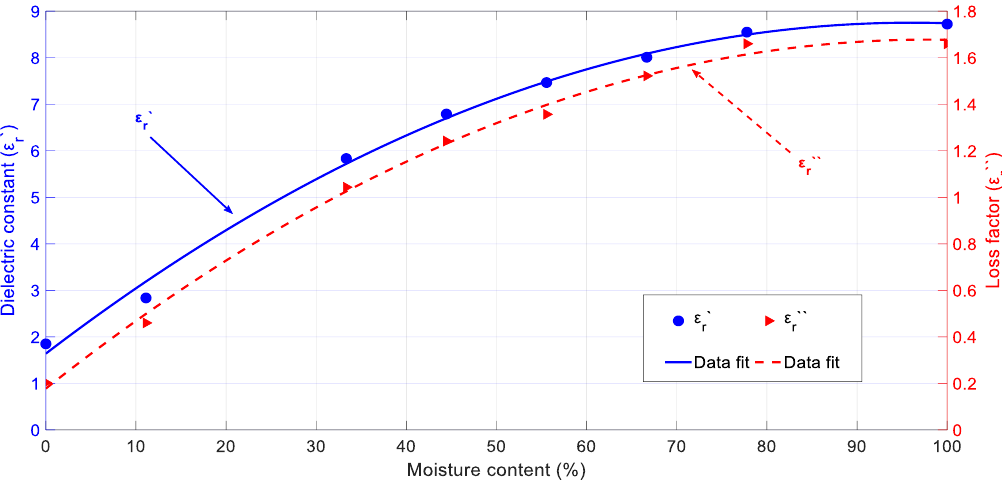
Figure 8. Dielectric properties for rockrose depending on the moisture content (dry basis) for a 0.43 g/cm 3 initial density and room temperature (24 °C).